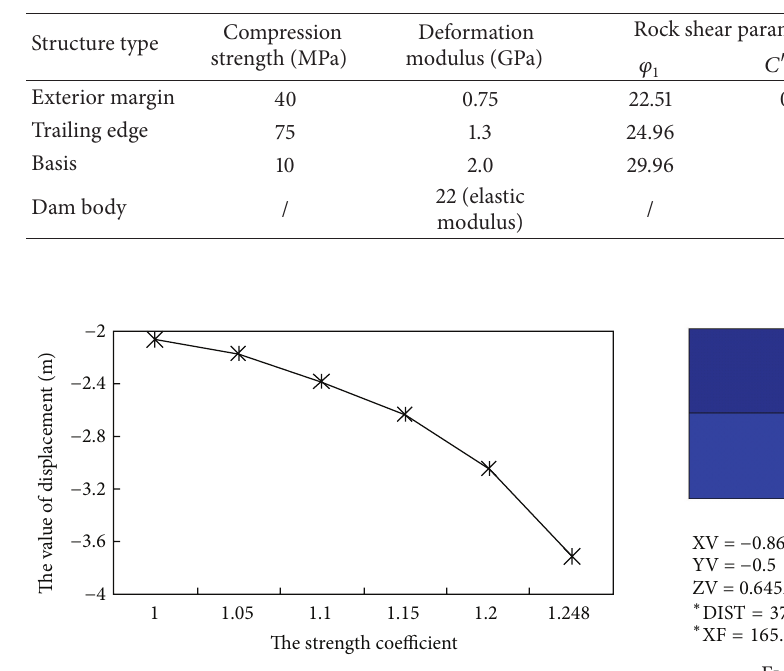
Table 6: Material parameters.